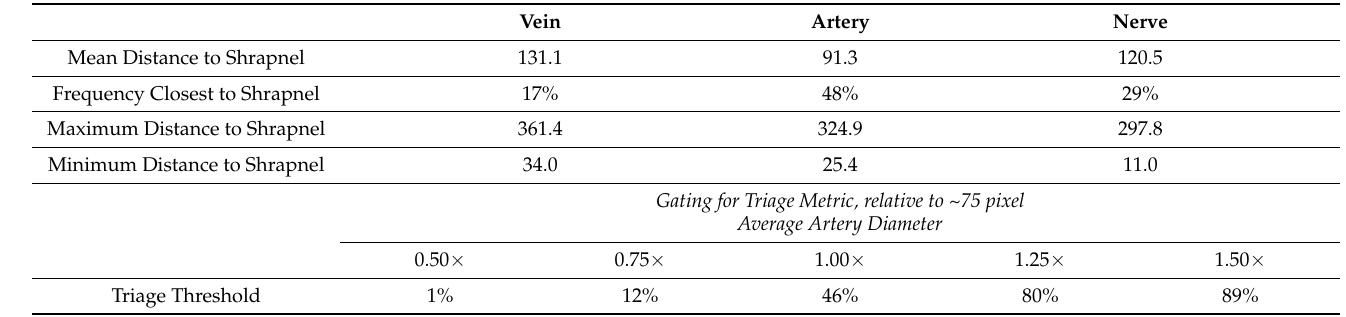
Table 2. Summary table of statistics for triage metric. Distances to each of three features (in pixels), and percentage of images that would be flagged for five different gating windows, based on an average artery size of ~75 pixels in the